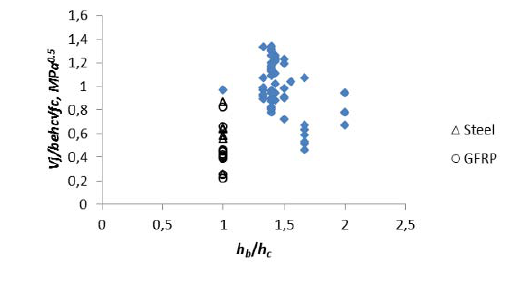
Figure 16. Influence of joint aspect ratio.